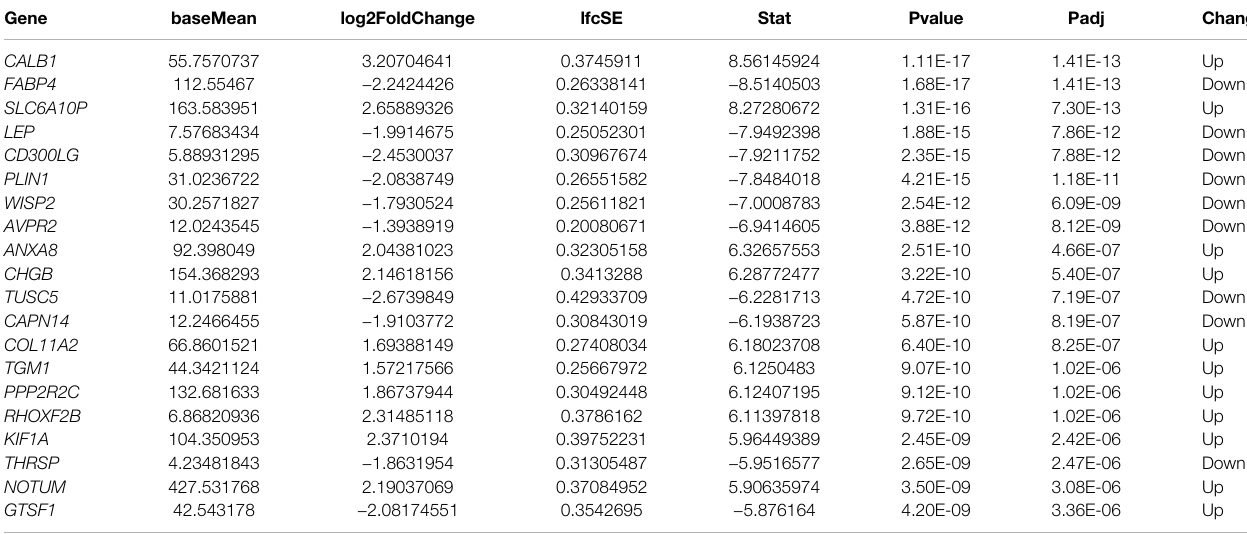
TABLE 2 | DEGs between two genomic variation clusters (top20, Cluster1 vs.